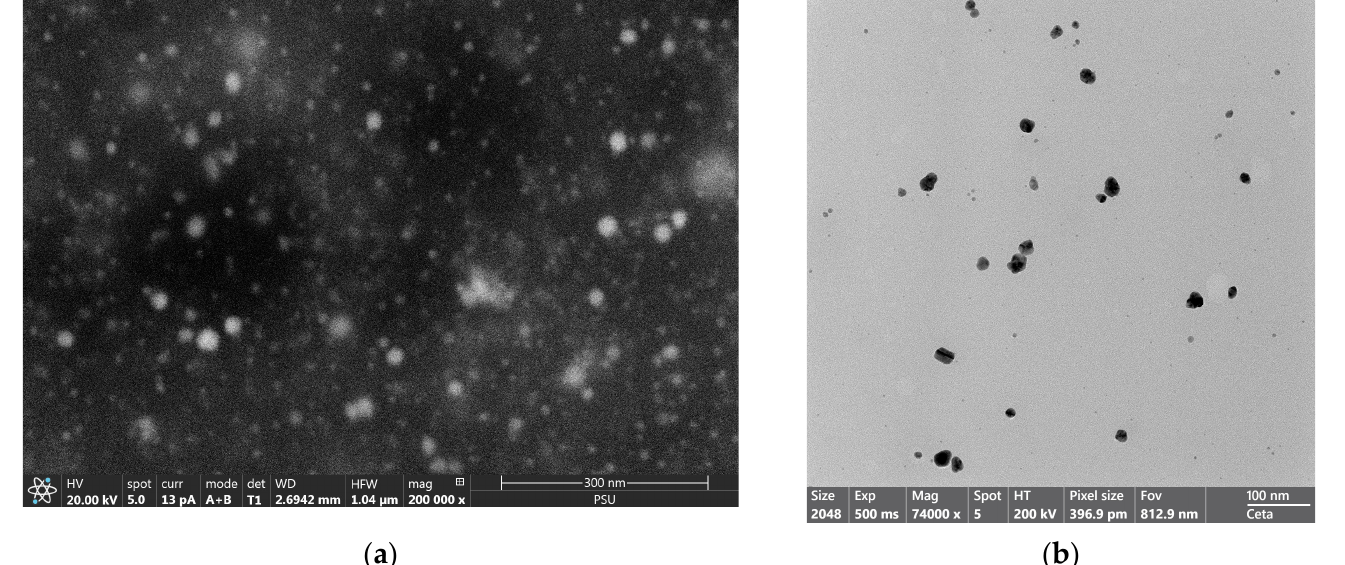
Figure 7. ( a ) SEM: 200,000× and ( b ) TEM: 74,000× images of silver-nanoparticle-complexed G. applanatum produced under optimal conditions.